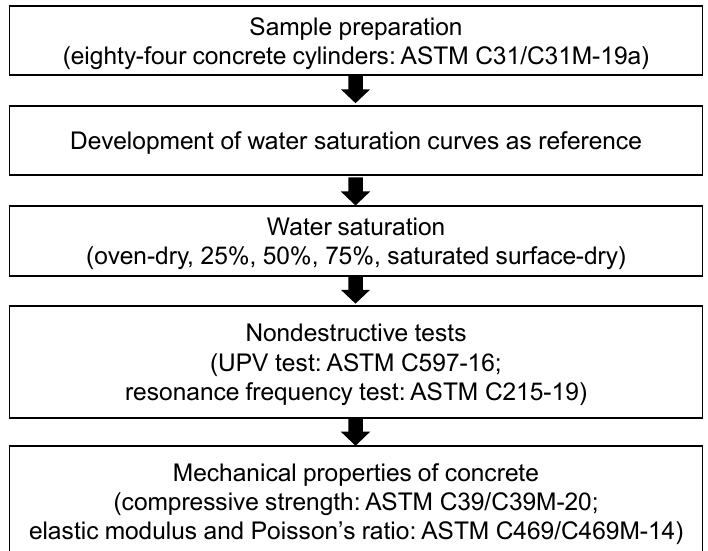
Figure 1. General research flow for this study.